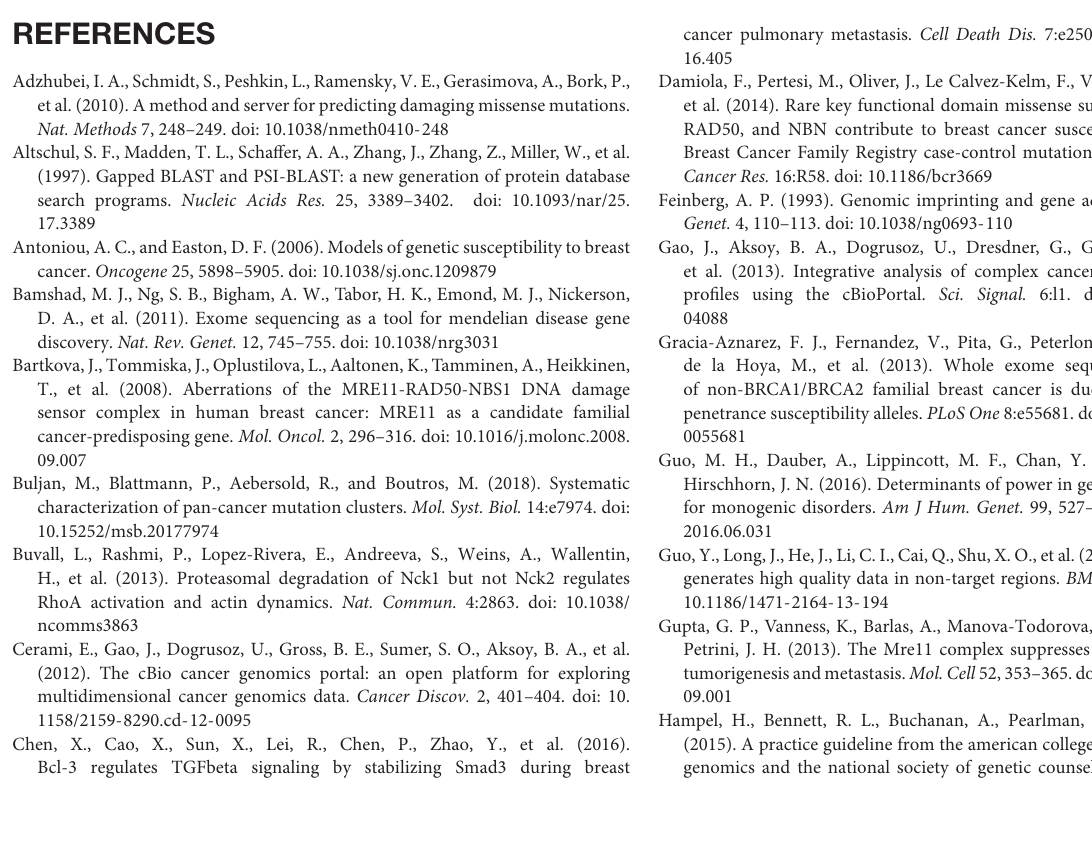
FIGURE S1 | Summary of NCK1 variations across TCGA studies. FIGURE S2 | Multiple sequence alignment of residue flanking R42 and D73 across 100 vertebrates. TABLE S1 | Variant filtering and classification parameters and the whole list of candidate genes. TABLE S2 | The allele count and allele number of the non-silent NCK1 mutations retrieved from genomAD and the burden test result. TABLE S3 | Hotspot analysis of NCK1 somatic mutations. TABLE S4 | All CHEK2 variants identified from the